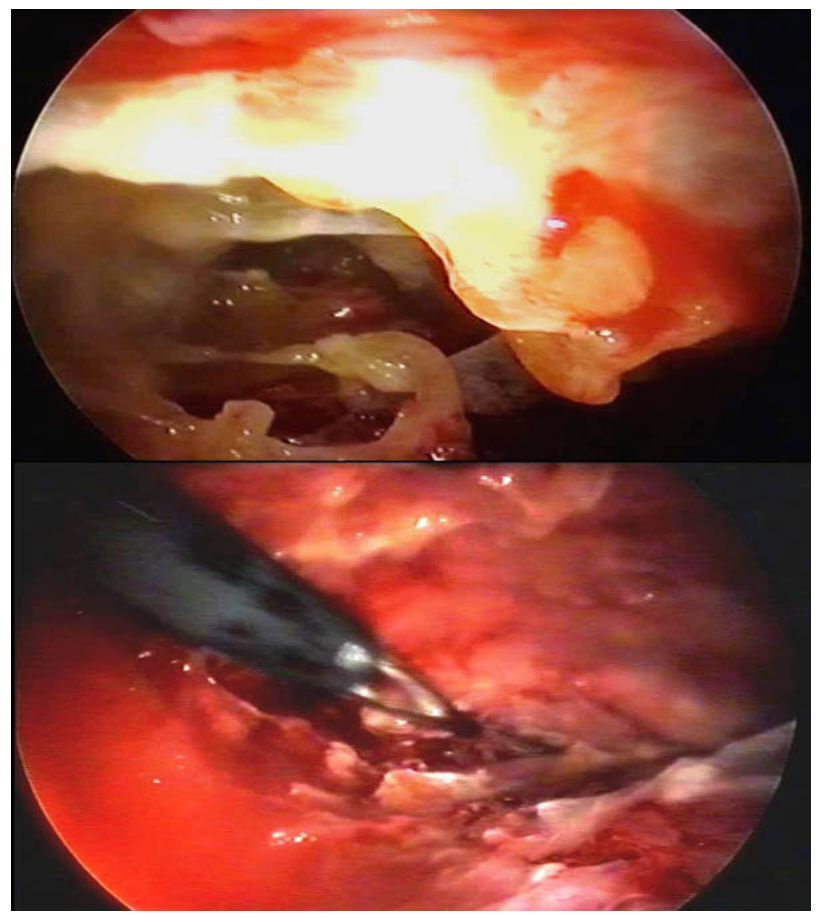
FIGURE 2. Pleural cavity loculations during videothoracoscopy CO 2 insufflation and